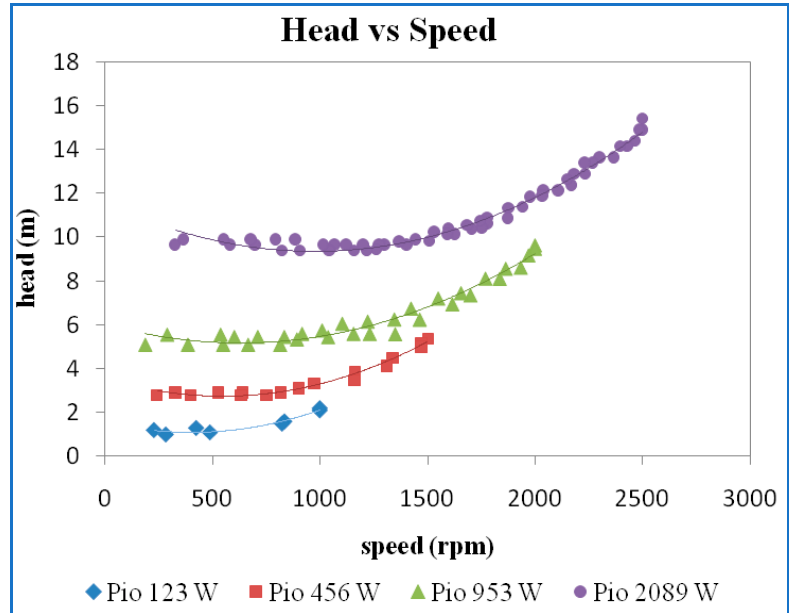
Figure 12. Head vs. speed at a guide vane opening of 13 mm.